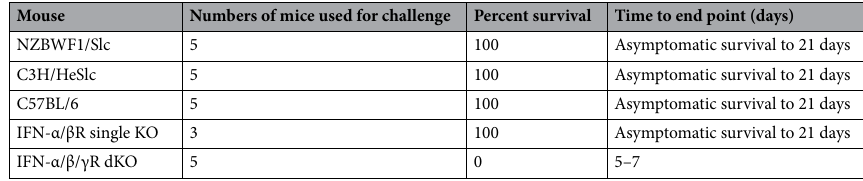
Table 1. Challenge of DV2ChimV in mice.